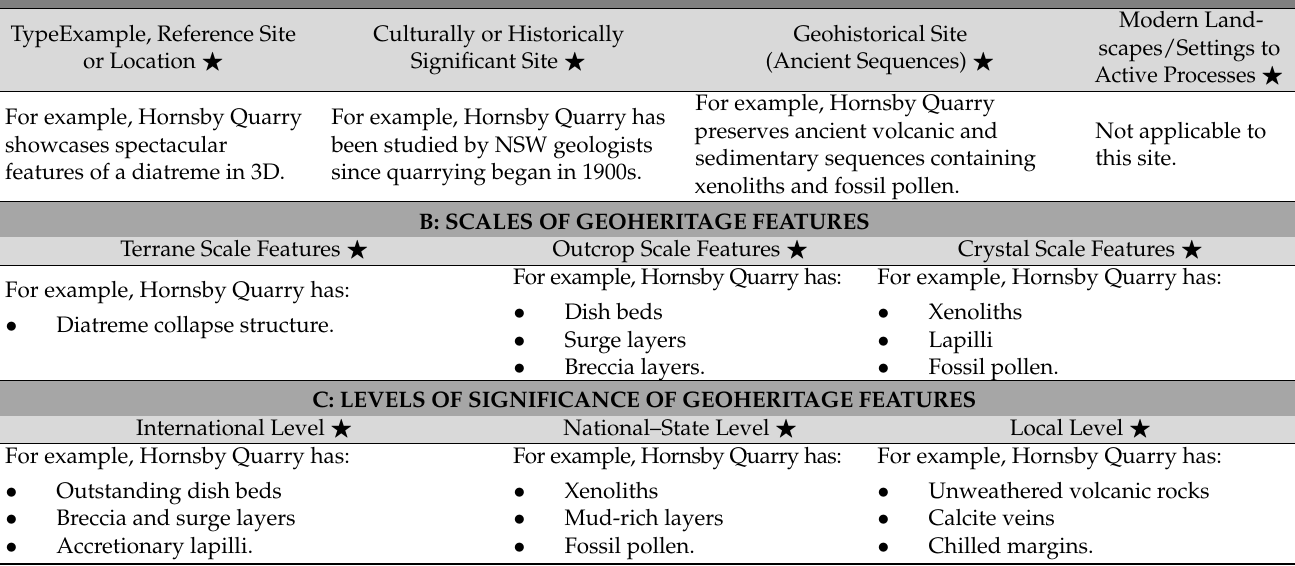
Table 3. Geoheritage categories relevant to an assessment of the Hornsby Quarry, based on the Geohertitage Tool-kit [13–15] (Stars indicate aspects applicable to the Hornsby Diatreme, as used in case studies outlined in